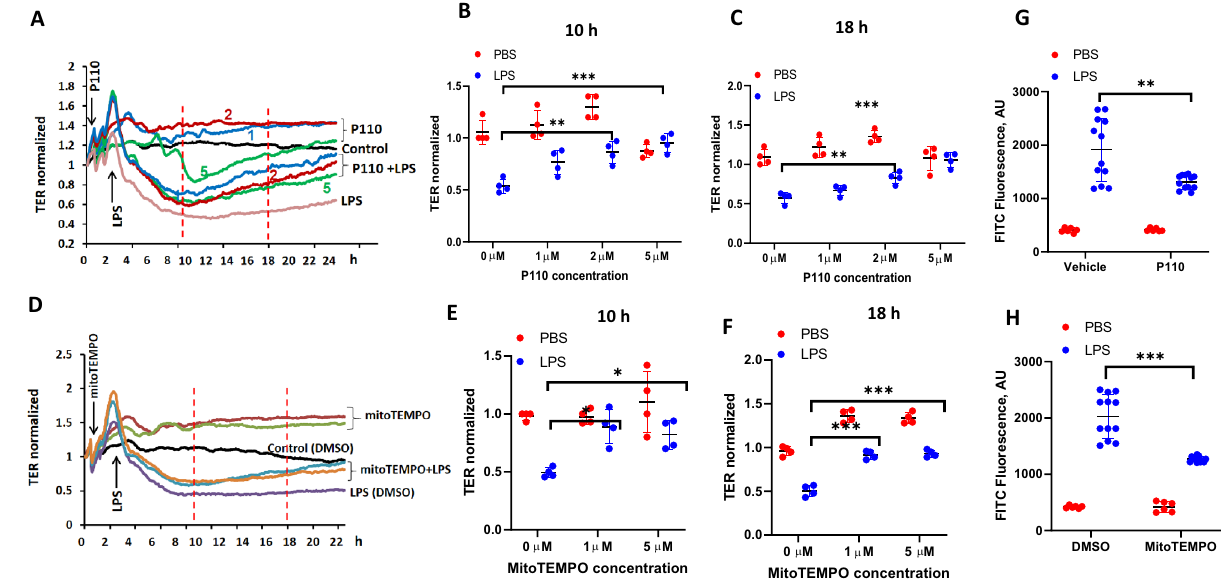
Figure 9. Inhibition of mitochondrial ROS attenuated LPS-induced HLMVEC barrier permeability. The effects of mitochondrial ROS on endothelial barrier function were tested by measurements of trans-endothelial electrical resistance (TER) ( A – F ) and FITC-dextran leakage ( G , H ). HLMVECs were pretreated with different concentrations of P110 (1–5 µM) or MitoTEMPO (1 or 5 µM) for 30 min followed by LPS (100 ng/ ml) challenge. TER was recorded continuously for 24 h ( A , D ). Shown are representative tracings from 4 independent experiments. The TERs at 10 h and 18 h time points were used for statistical analysis ( B , C & E , F ). ( B , C ) Values are means ± SD. **p < 0.01, P110 2 μM versus LPS control, n = 4; ***p < 0.005, P110 5 μM versus LPS, n = 4. ( E , F ) Values are means ± SD. *p < 0.05, MitoTEMPO 1 or 5 μM versus LPS; ***p < 0.005, MitoTEMPO 1 or 5 μM versus LPS, n = 4. ( G , H ), HLMVECs monolayer permeability was assessed by FITC-dextran leakage as describe in METHODS. Values are means ± SD. **p < 0.01, P110 + LPS versus LPS, n = 4; ***p < 0.005, MitoTEMPO + LPS versus LPS, n =